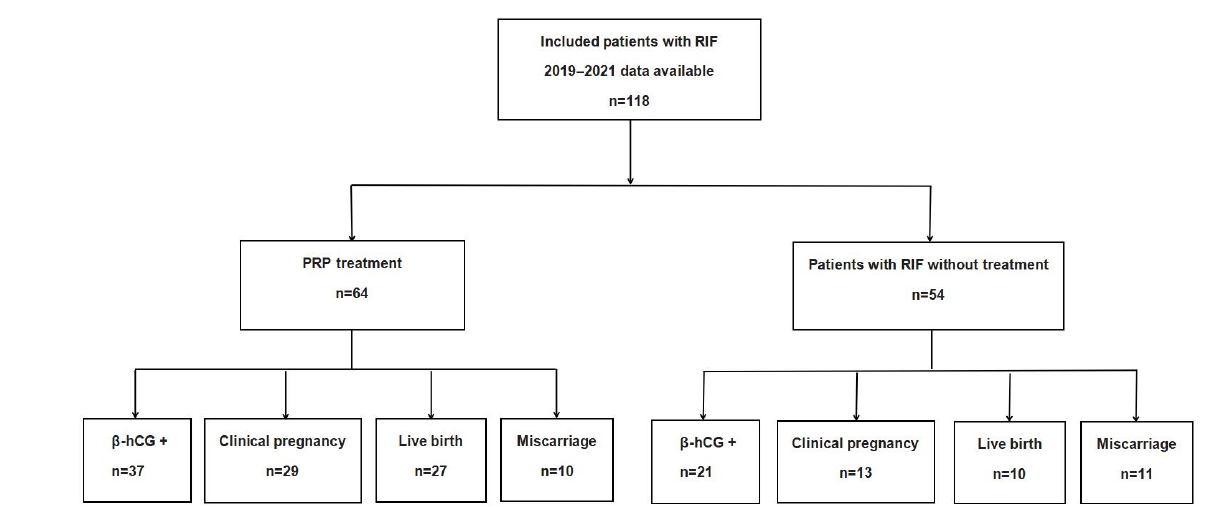
Figure 1. Flow chart of the study population.